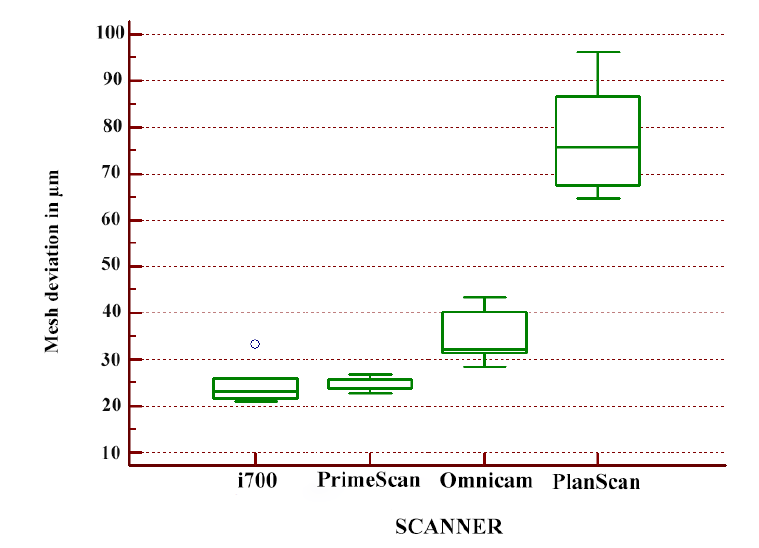
Figure 3. Boxplot displaying the trueness values of the four intraoral